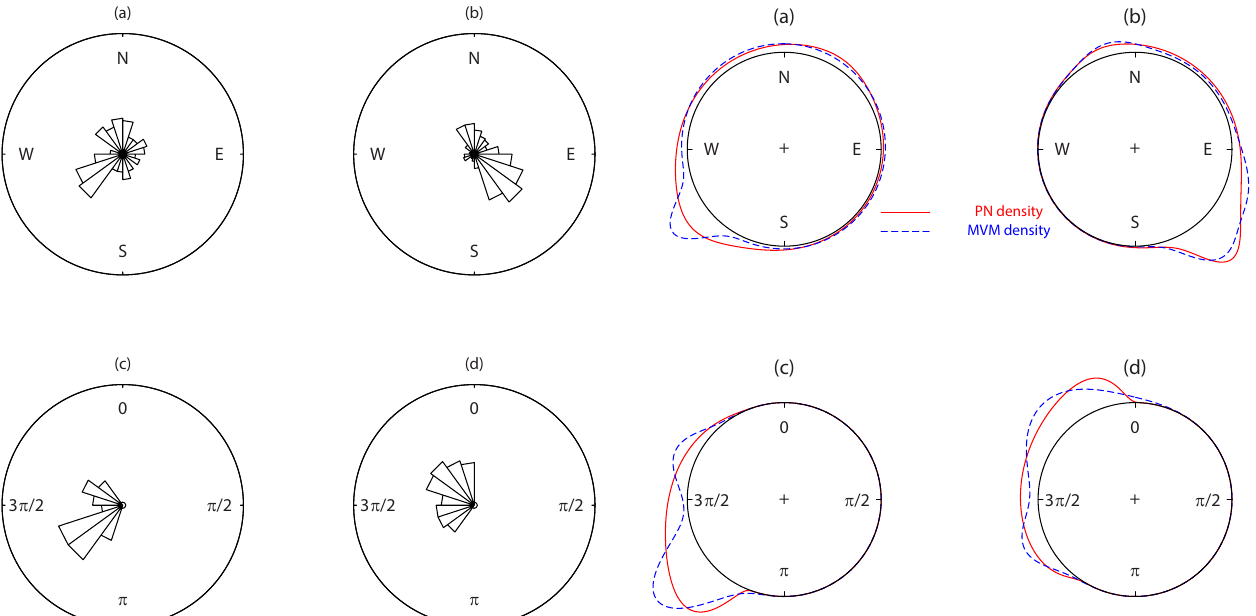
Figure 2. Density of fitted projected normal distributions (PN) and a mixture of von Mises distributions (MVM) wrapped around the cir- cle: direction of dip for (a) the Sherwood Sandstone group and (b) the Windermere Supergroup; orientations (doubled from the origi- nal range of [0 ,π ]) for (c) Bangladesh anticline axial planes and (d) Bangladesh Landsat-derived